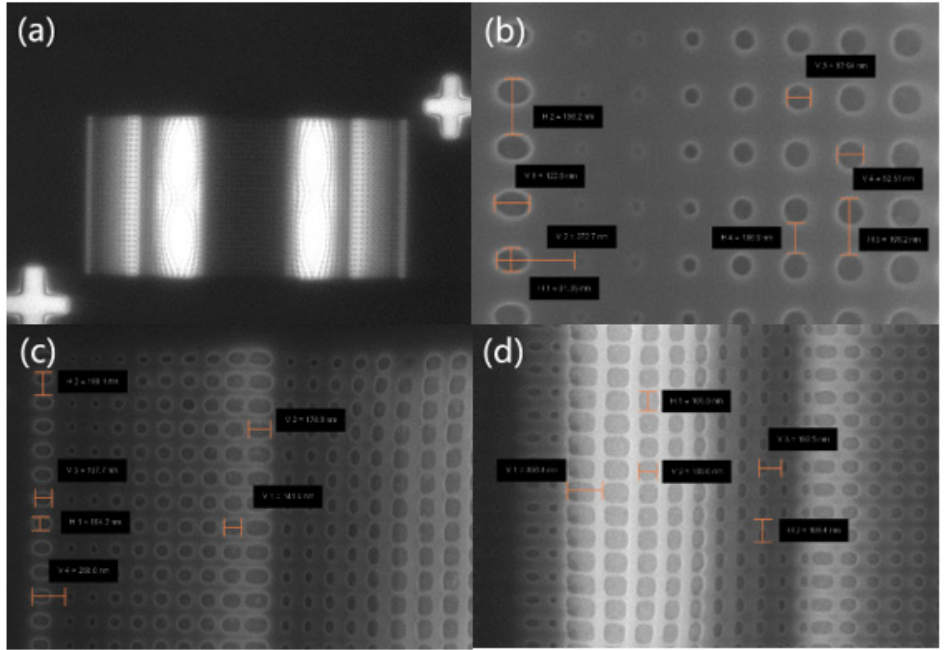
Figure 4. SEM images of different exposure doses: ( a ) the SEM image with an exposure dose of 700 700 µ C/cm 2 ; ( b ) the SEM image with an exposure dose of 400 µ C/cm 2 ; ( c ) the SEM image with an μ C/cm 2 ; ( b ) the SEM image with an exposure dose of 400 μ C/cm 2 ; ( c ) the SEM image with an exposure dose of 500 µ C/cm 2 ; ( d ) the SEM image with an exposure dose of 600 µ C/cm 2 exposure dose of 500 μ C/cm 2 ; ( d ) the SEM image with an exposure dose of 600 μ C/cm 2 .